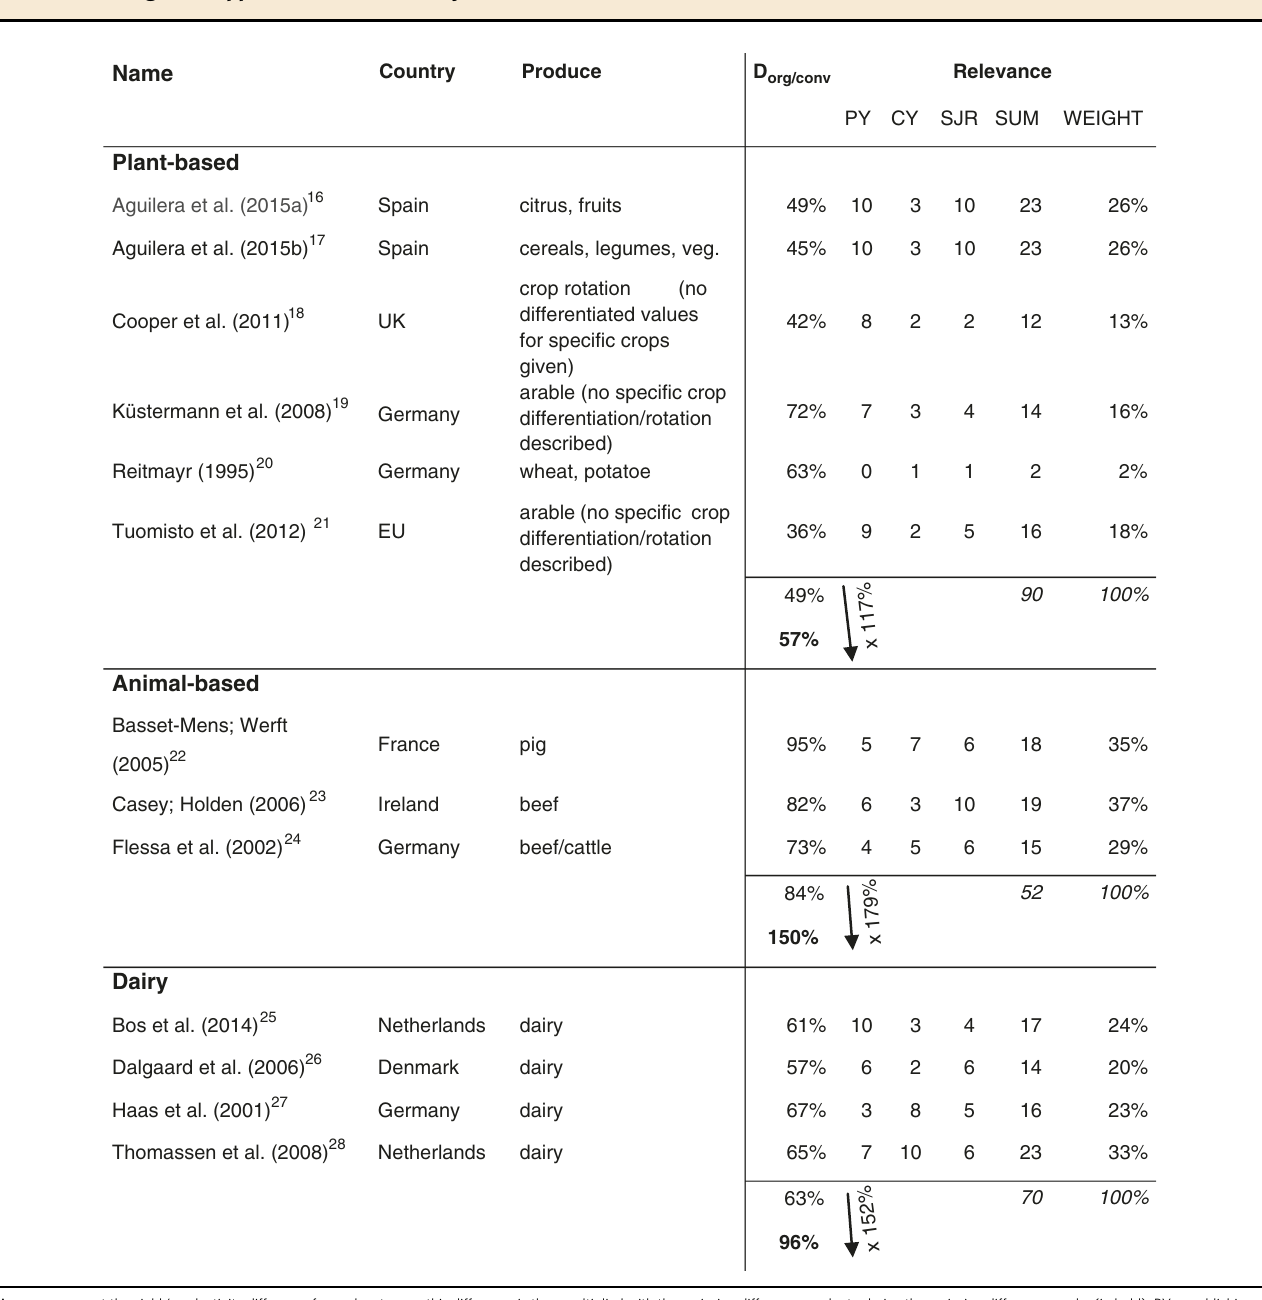
Table 2 Determining the emission difference ( D org/conv ) between organic and conventional production in different countries ’ contexts through the application of meta-analytical methods.